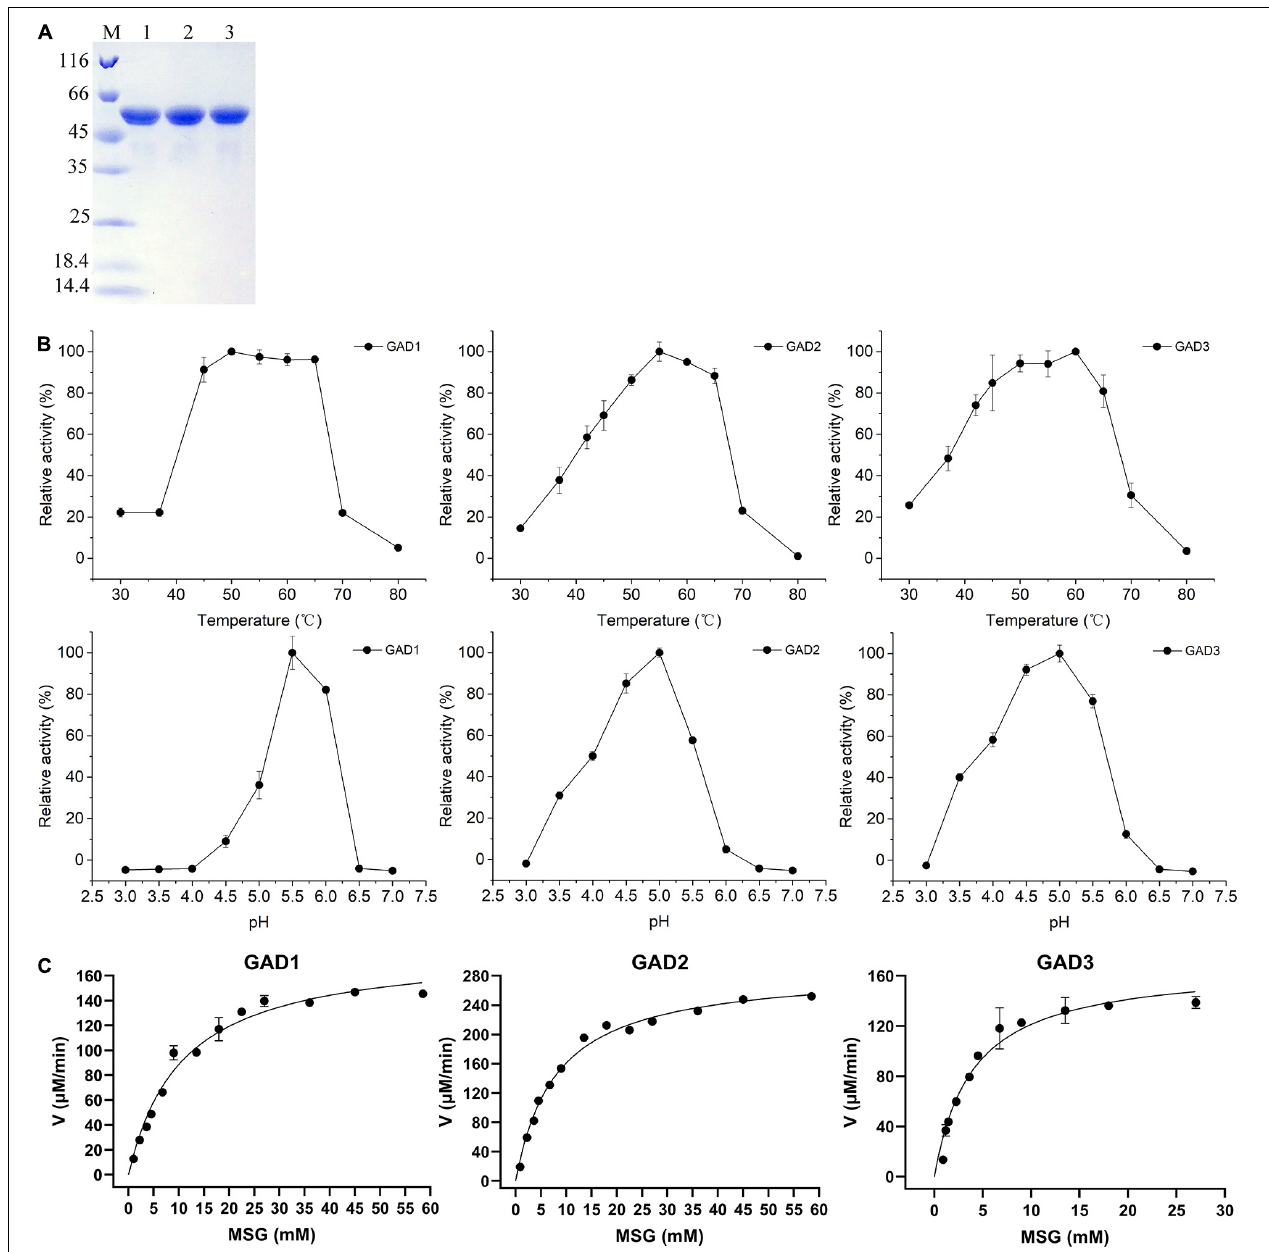
FIGURE 3 | Purification and properties of the recombinant GADs. (A) SDS-PAGE of three GADs. Lane M, PierceTM Unstained Protein MW Marker (Thermo Fisher Scientific, United States), size range shown were 116, 66, 45, 35, 25, 18.4, and 14.4 kDa; lane 1, purified GAD1; lane 2, purified GAD2; lane 3, purified GAD3. (B) Effects of temperature and pH value on GAD activities and (C) the kinetic parameters of three GADs with MSG as substrate under optimal conditions.